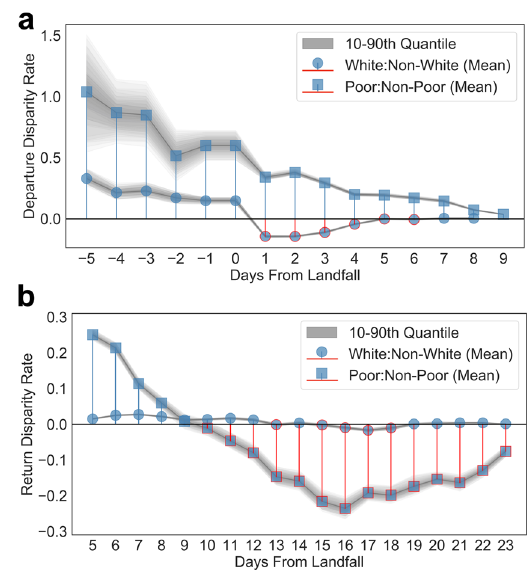
Fig. 4 Time progression of class and racial disparity in evacuation and return. The vertical axis shows the relative disparity in the cumulative numbers of departures ( a ) and returns ( b ) over time, between residents of poor vs. non-poor neighbourhoods (squares), and white vs. non-white neighbourhoods (circles). A positive value on a given day indicates a disproportionate number of people from white or non-poor neighbourhoods having evacuated (returned) up to that